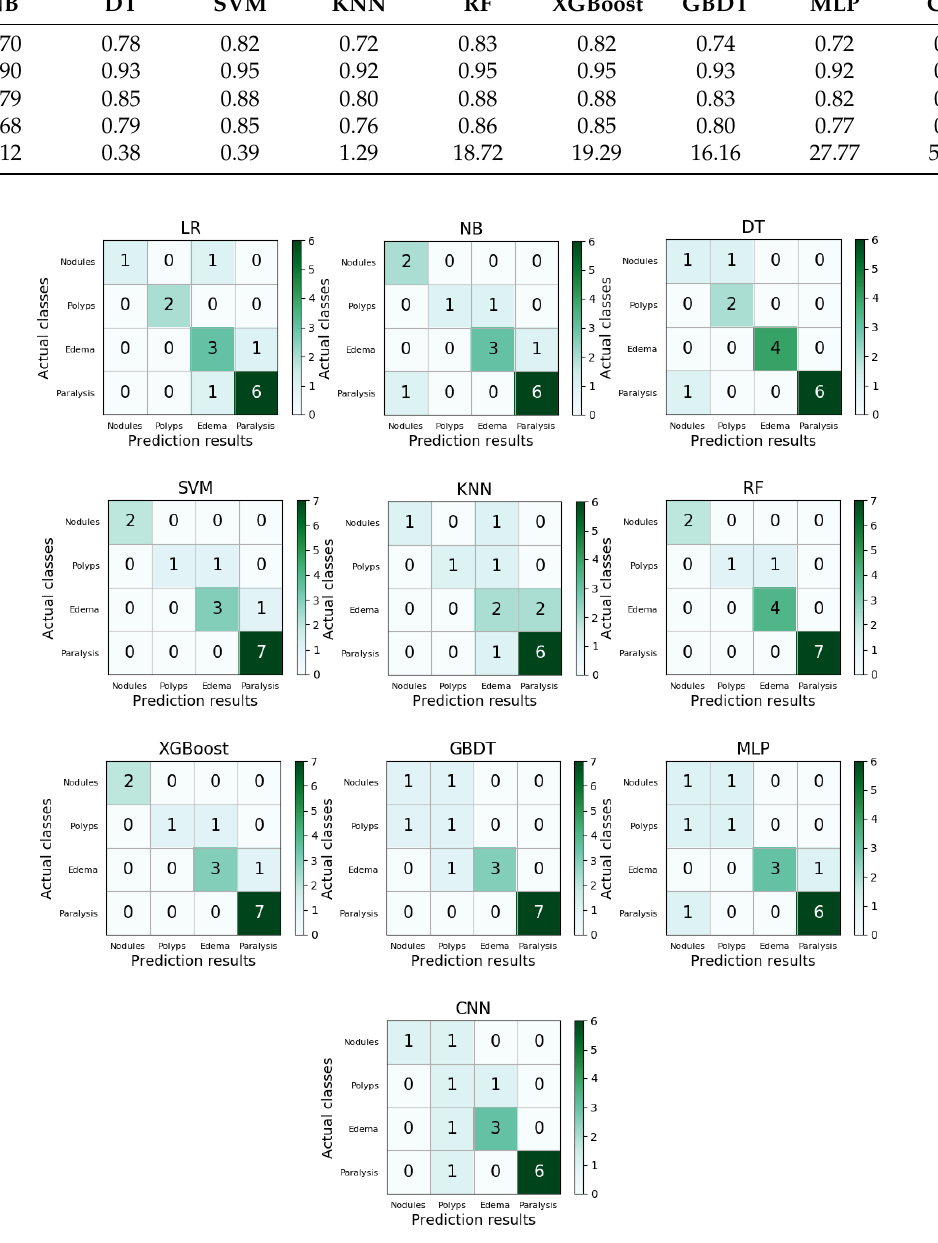
Figure 5. The multi-class confusion matrices of logistic regression(LR), naive Bayes (NB), decision tree (DT), support vector machine (SVM), K nearest neighbours (KNN), multi-layer perceptron (MLP) and random forest (RF) after FC-SMOTE